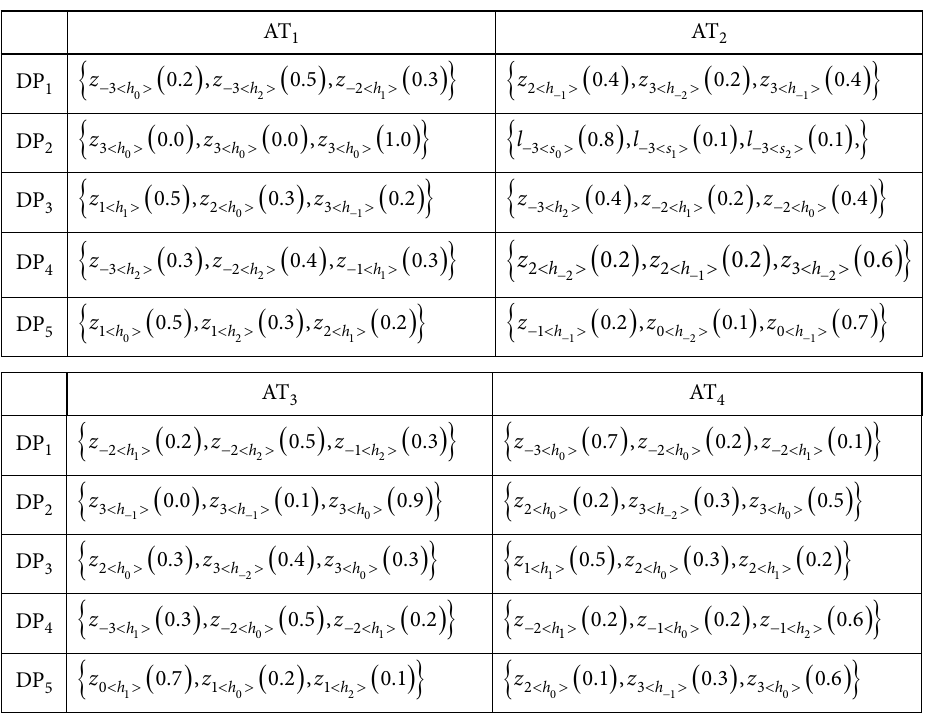
Table 3. The PDHLTSs evaluation of all alternatives is provided by e 3 AT 1 AT 2 DP